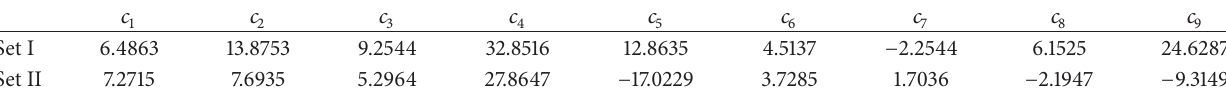
Table 4: Two sets of coefficients in (70).